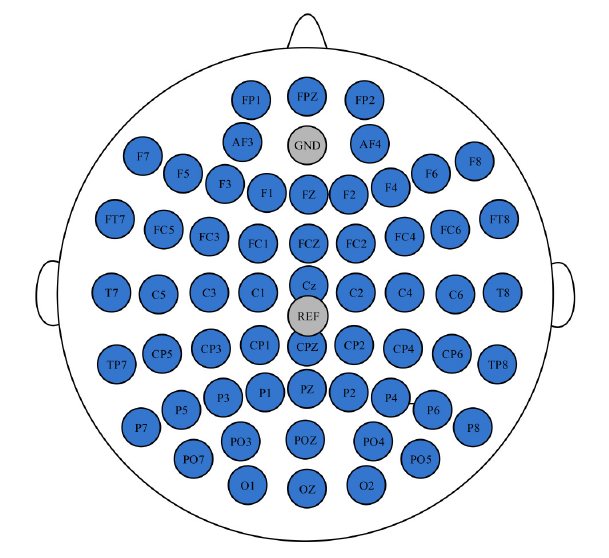
FIGURE 2 | The position of the selected electrodes and the Cz-REF.